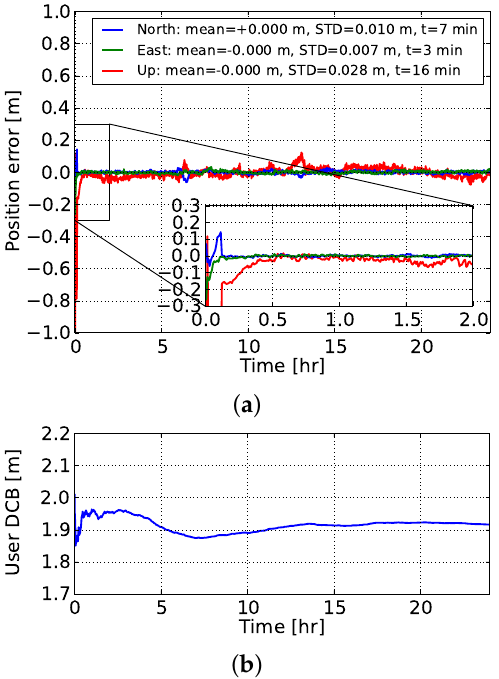
Figure 7. Time-series of ( a ) the GPS dual-frequency ionosphere-weighted FAR-based PPP-RTK kinematic user position for station NCWL with respect to its ground-truth, and ( b ) its associated network-user scaled DCB estimate. The ionospheric corrections were determined from network #2. The empirical means and STDs are calculated for the estimated positions after 2 h. A zoom-in window during the first 2 h is